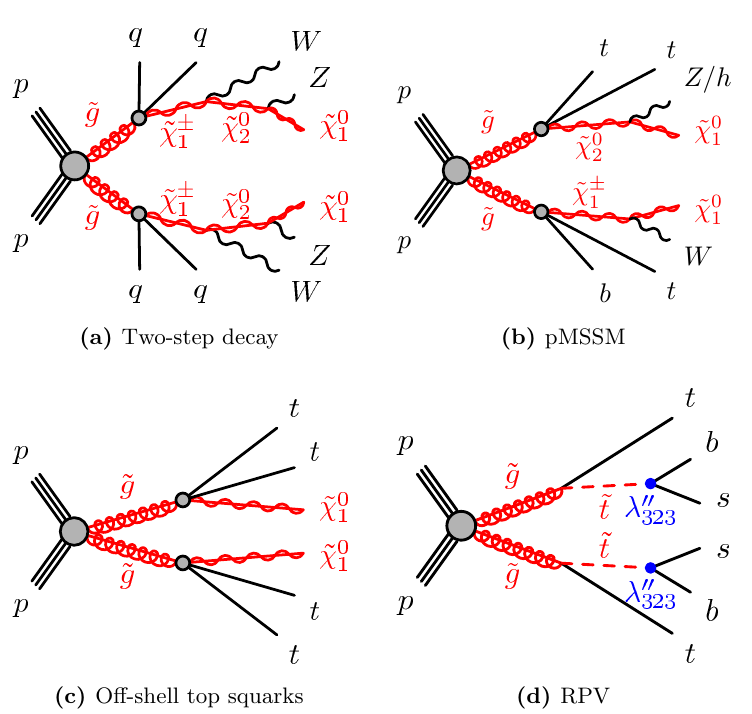
Figure 1. Pseudo-Feynman diagrams for the di(cid:11)erent signal models used in this search. high E miss